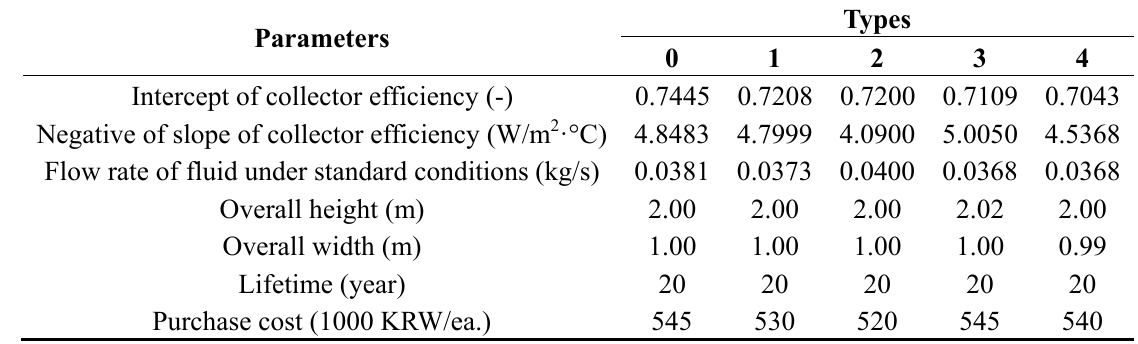
Table A1. Technical and economic parameters of the solar collectors for each case.